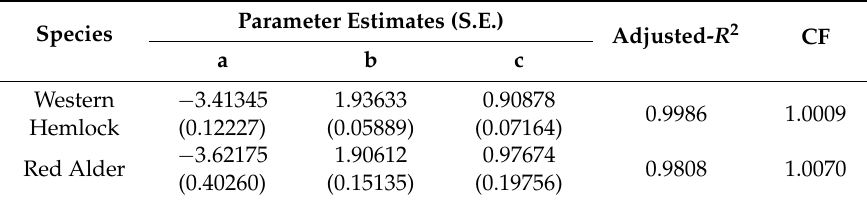
Table 4. Parameter estimates and their standard errors for the log–log model (Equation (22)) to estimate total aboveground biomass in Western hemlock and red alder trees. CF is the log-bias correction factor calculated as